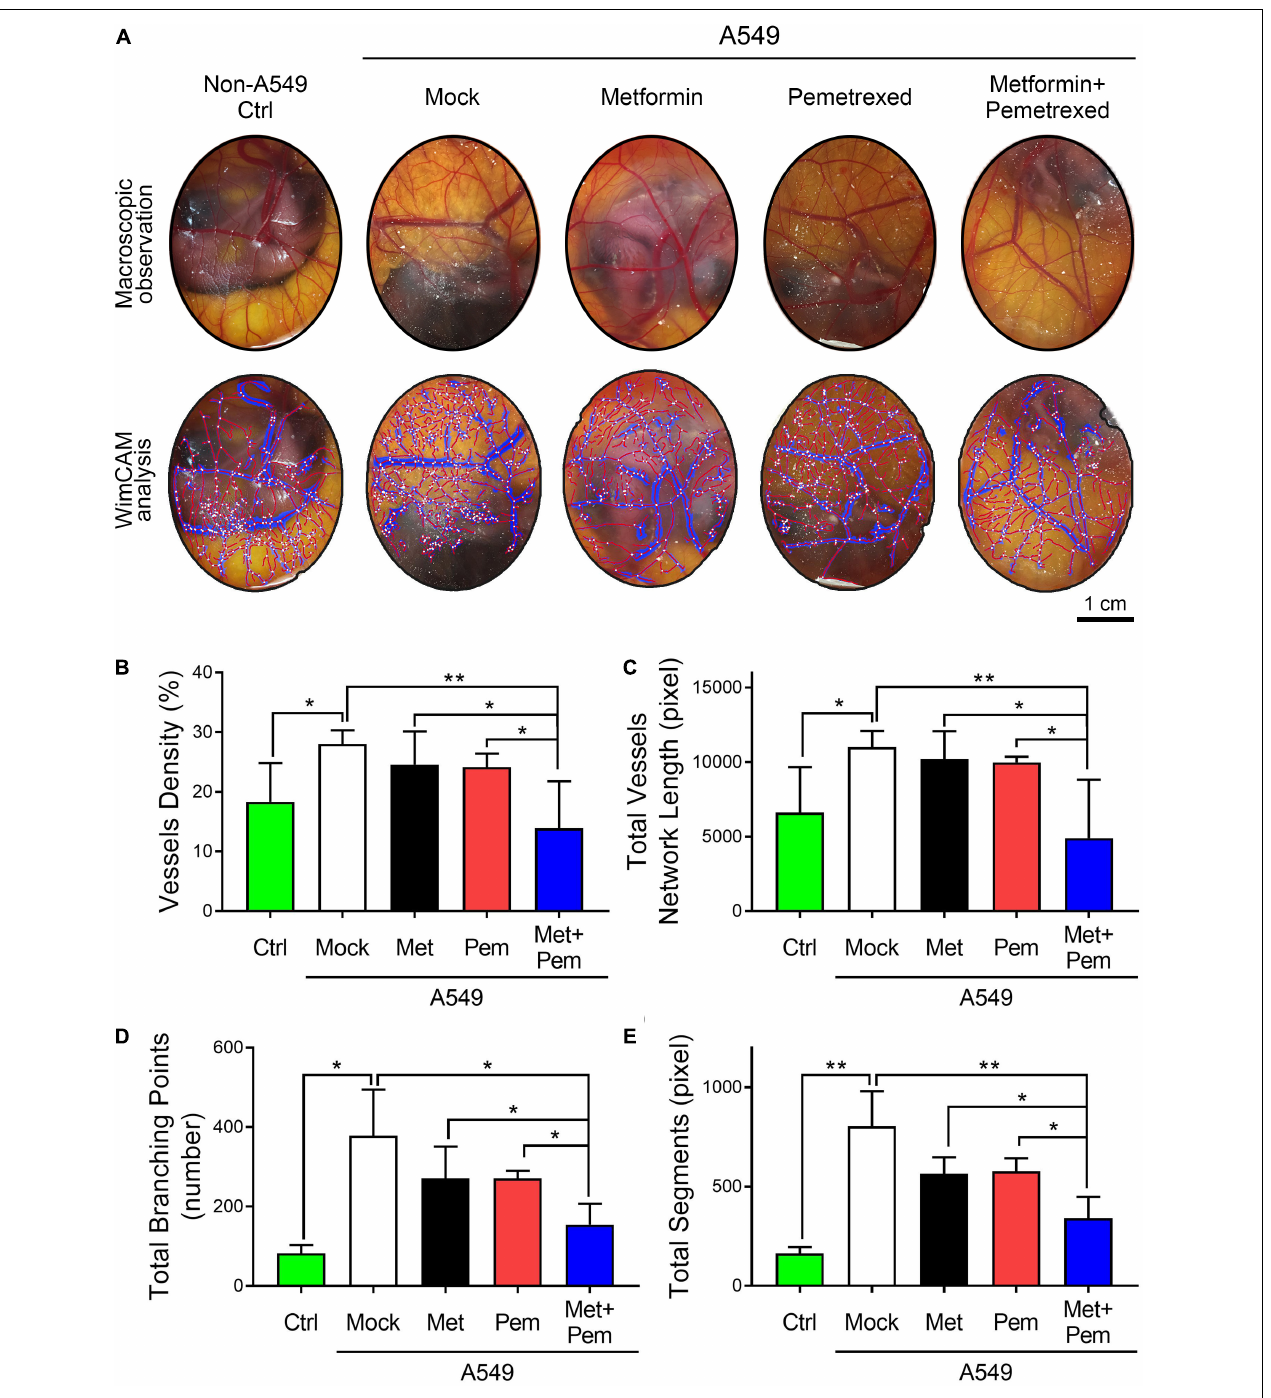
FIGURE 4 | The combination of metformin with pemetrexed attenuated A549 cell-induced angiogenesis in a chick embryo chorioallantoic membrane (CAM) assay. (A) The upper panel shows the blood vessel plexus of 14-day-old chicken embryos following A549 xenograft metformin (0.1 mg/egg) and/or pemetrexed (0.02 mg/egg) treatment. The lower panel shows the WimCAM analysis results in which vessel structure (blue), vessel skeleton (red) and branching points (white) are marked. The statistical bar chart shows (B) blood vessel density, (C) total blood vessel network length, (D) number of branching points, and (E) total blood vessel segments for the control, mock and treatment groups. Scale bars = 1 cm. Data are presented as the mean ± SD. those from 3–4 independent experiments with two technical replicates in each. * P < 0.05 and ** P < 0.01.